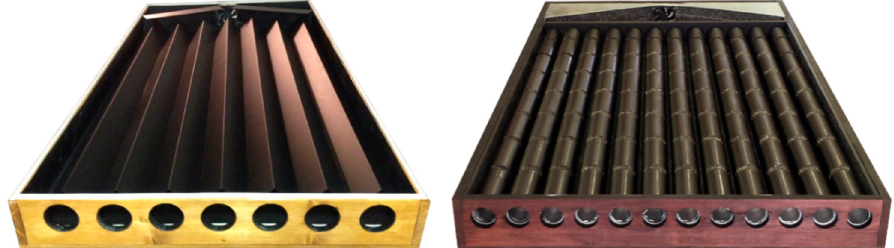
Figure 10. Comparison of the ( left ) original and ( right ) improved designs of the solar thermal collector .